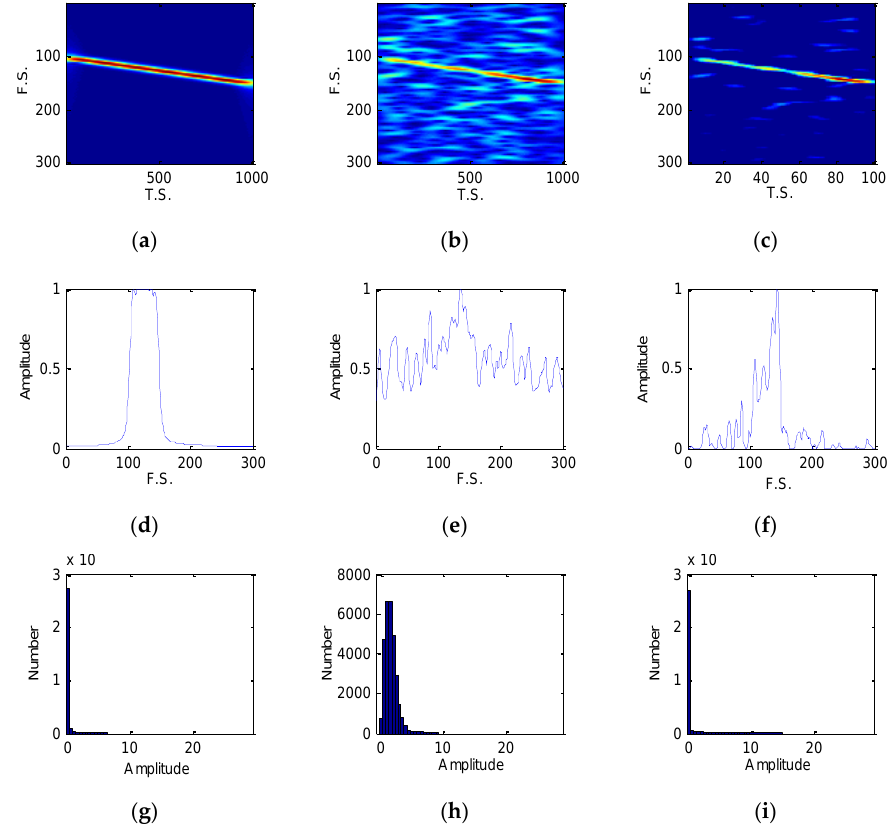
Figure 6. The results of STFT image, EC-STFT and the histogram of LFM signal: ( a , d , g ) for LFM signal without noise; ( b , e , h ) for LFM signal with noise ( − 5 dB); ( c , f , i ) for LFM signal after denoising.